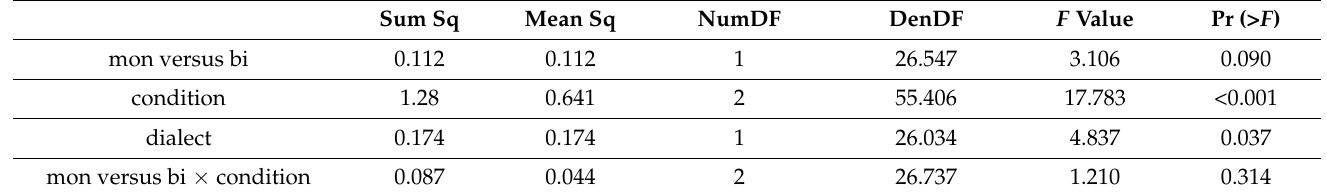
Table 6. Type III Analysis of variance table for the fixed effects tested in the reaction time experiment. The model includes monolinguals and bilingual